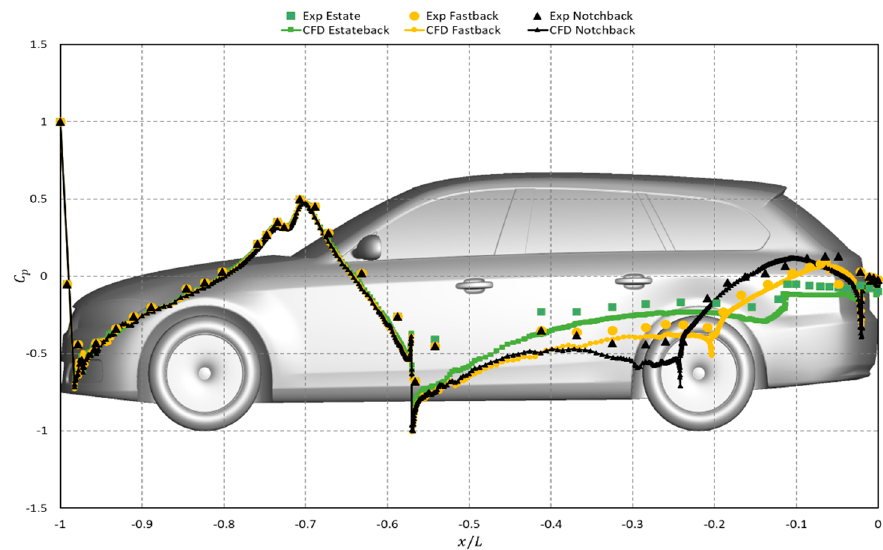
Figure 2. Centreline pressure coefficient comparison between CFD and experimental data obtained from [17] for the EB, FB, and NB geometries.